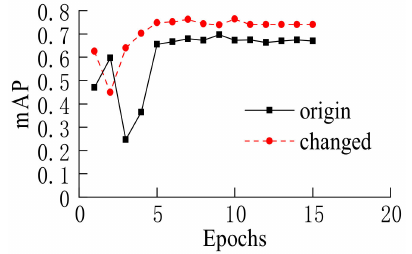
Figure 16. mAP of 0.75IoU.